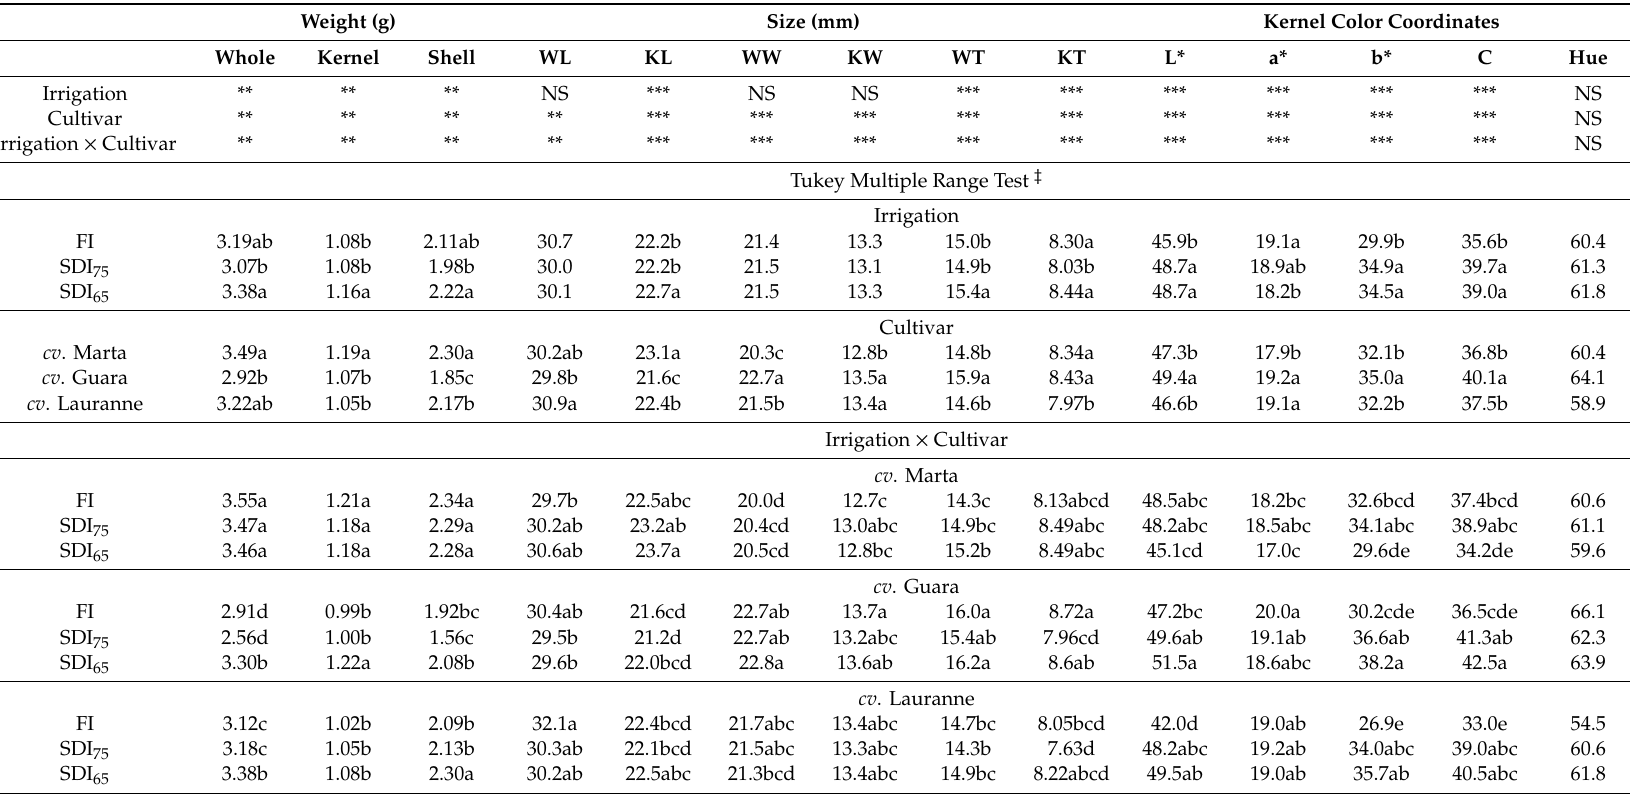
Table 3. Morphology and instrumental color of raw almonds as a ff ected by deficit treatment and almond